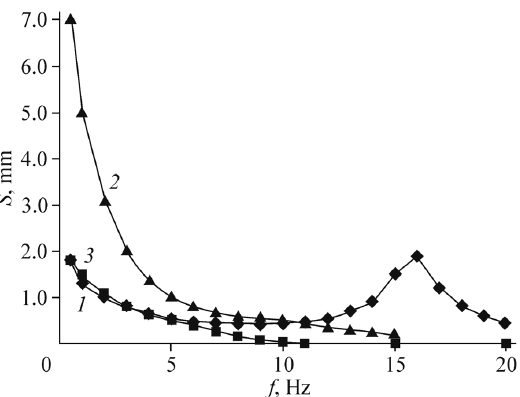
Figure 16. Frequency dependencies of the actuator displacement amplitude against sinusoidal applied voltage (the amplitude is 1 V) for (1) graphene electrodes on MF-4SK and (2, 3) flexible platinum electrodes researched in [39]: (2) Pt/Nafion (125- μ m thick); (3) Pt/MF-4SK (120- μ m thick). Reproduced from [40] with permission from Springer Nature. Copyright 2020.